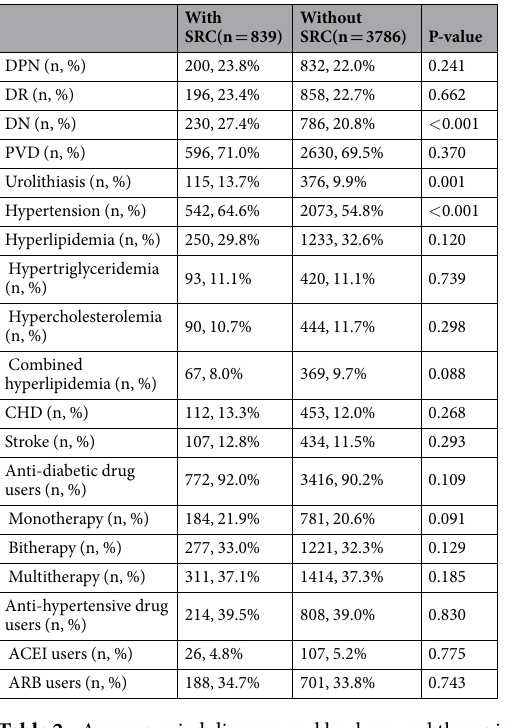
Table 2. Accompanied diseases and background therapies of subjects with and without SRC. Categorical variables were expressed as percentages and compared by the Chi-square test. SRC, simple renal cysts; DPN, diabetic peripheral neuropathy; DR, diabetic retinopathy; DN, diabetic nephropathy; PVD, peripheral vascular disease; CHD, coronary heart disease; ACEI, angiotension converting enzyme inhibitors; ARB, angiotensin receptor blocker.